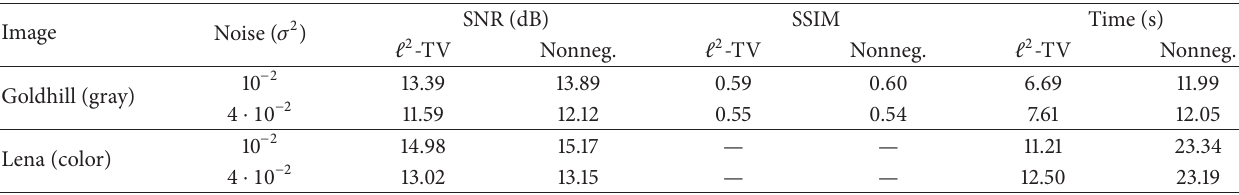
Table 1: Deconvolution performance results for the standard ℓ 2 -TV and for the nonnegative ℓ 2 -TV methods for the grayscale “Goldhill” ( 720 × 576 ) image and the color “Lena” ( 512 × 512 ) image.